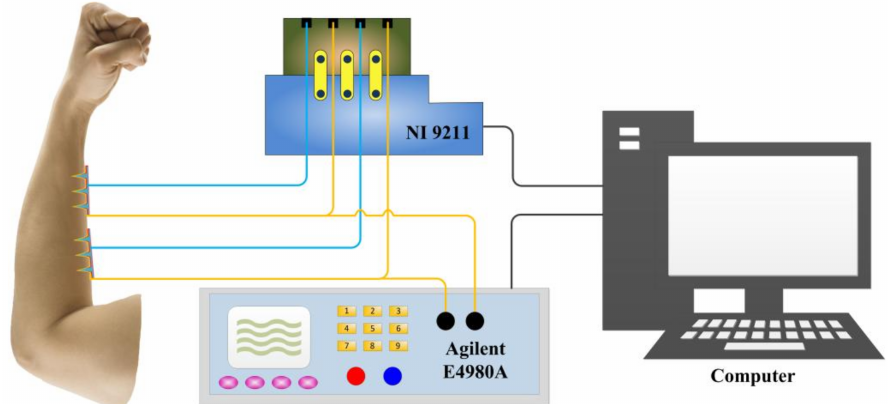
Figure 3. Comprehensive detection of EII and temperature with the